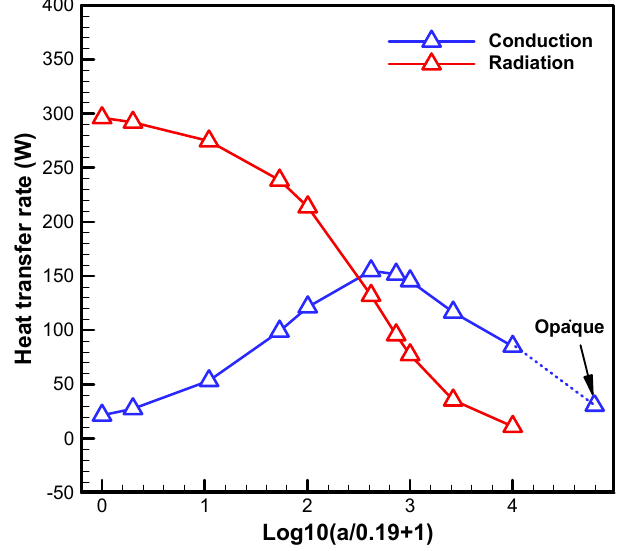
Log10(a/0.19+1) Figure 6. Heat transfer rates at the bottom central surface of the crystal with different coefficient absorptions. The variations of the maximum temperature gradient and maximum thermal stress at the bottom of the crystal with the changing absorption coefficient, as shown in Figure 7, present the same tendency as the conduction heat transfer rate does because the conduction heat transfer rate directly determines the temperature gradient. However, it is surprising that the peak values of the profiles of the maximum temperature gradient and maximum thermal stress are located at different absorption coefficients, which are 79 m − 1 and 10 m − 1 , respectively. To explain this observation, the local distributions of the temperature gradient under these two absorption coefficients are compared